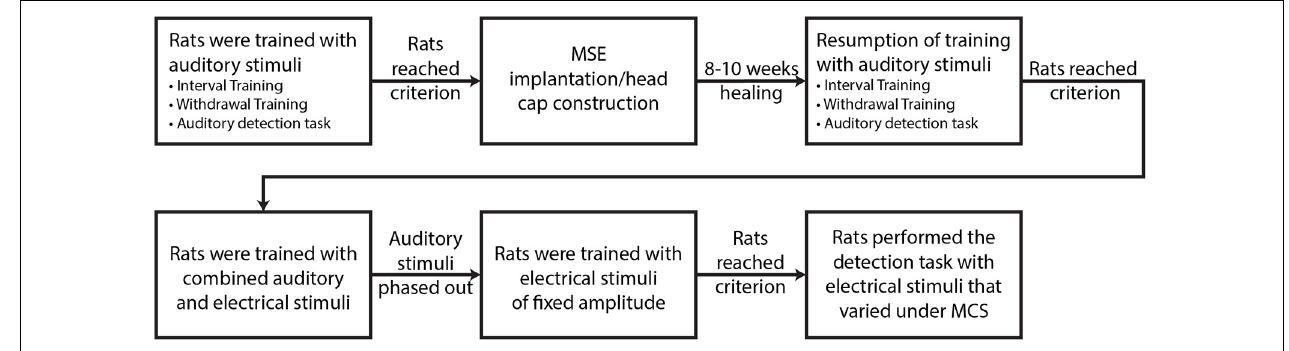
FIGURE 2 | Main stages of experimental